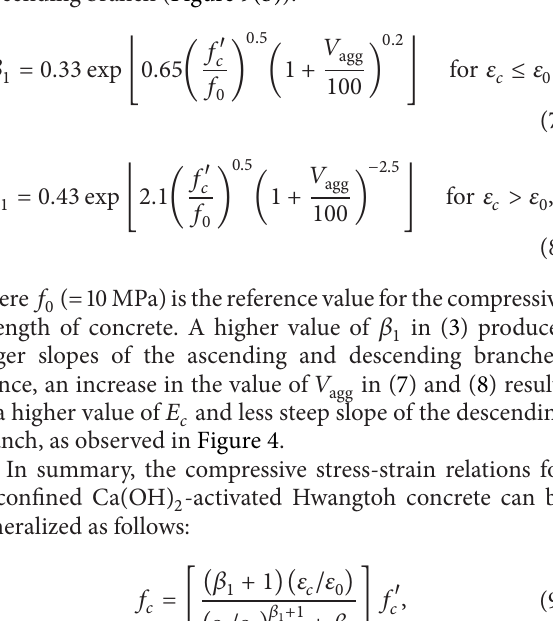
Figure 9: Formulation of 𝛽 1 through numerical